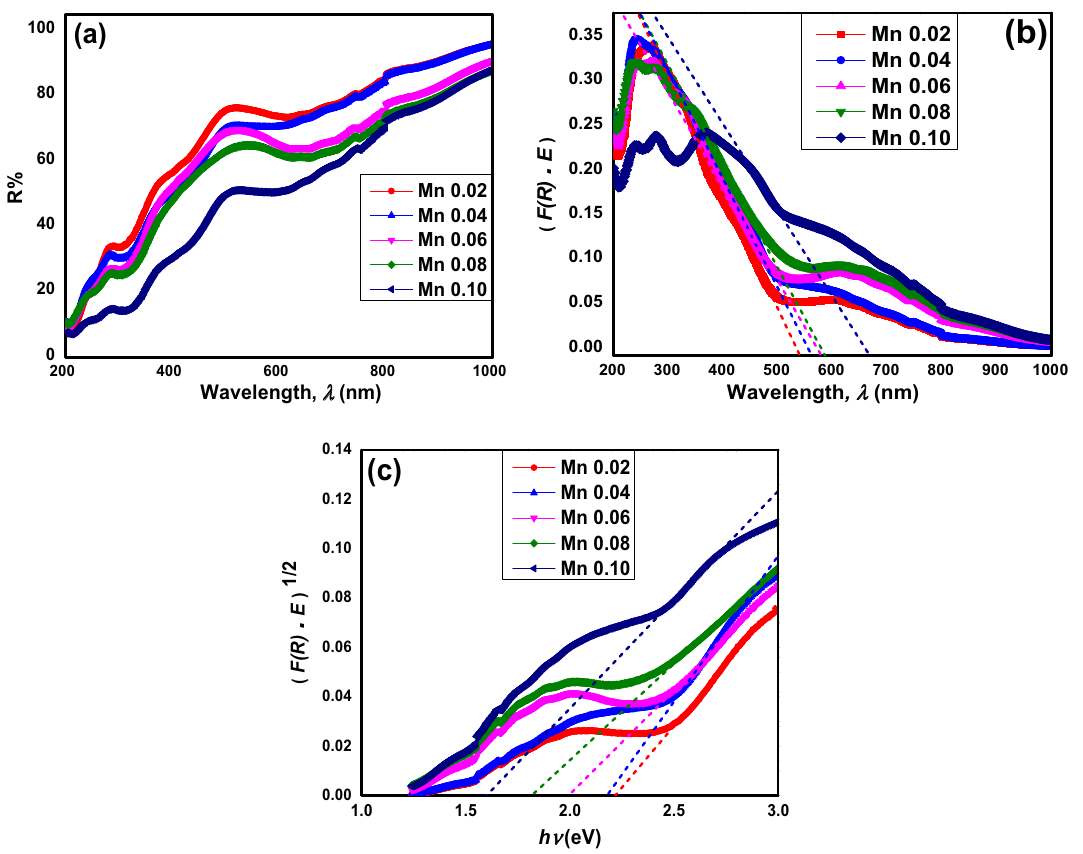
Figure 5. ( a ) The diffuse reflectance, ( b ) Kubelka–Munk, and ( c ) Tauc plotting of SrLaLiTe 1− x Mn x O 6 (dotted line are the fitting for optical band gap).